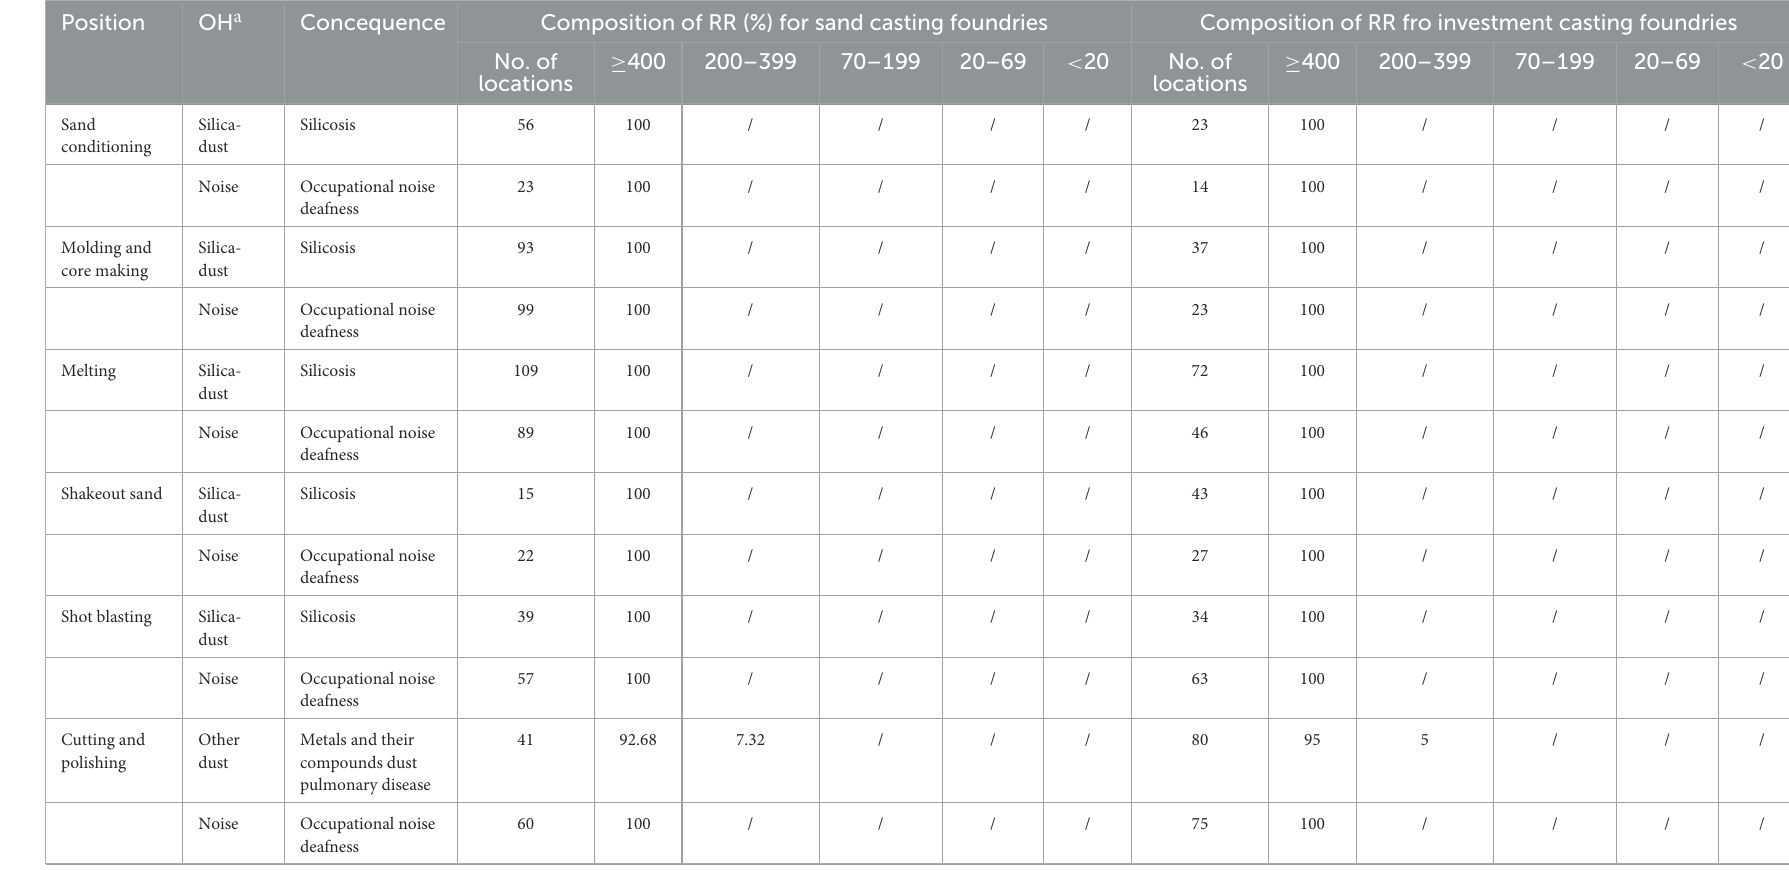
TABLE 4 Composition of risk ratios (RRs) of different positions for sand casting foundries and investment casting foundries.